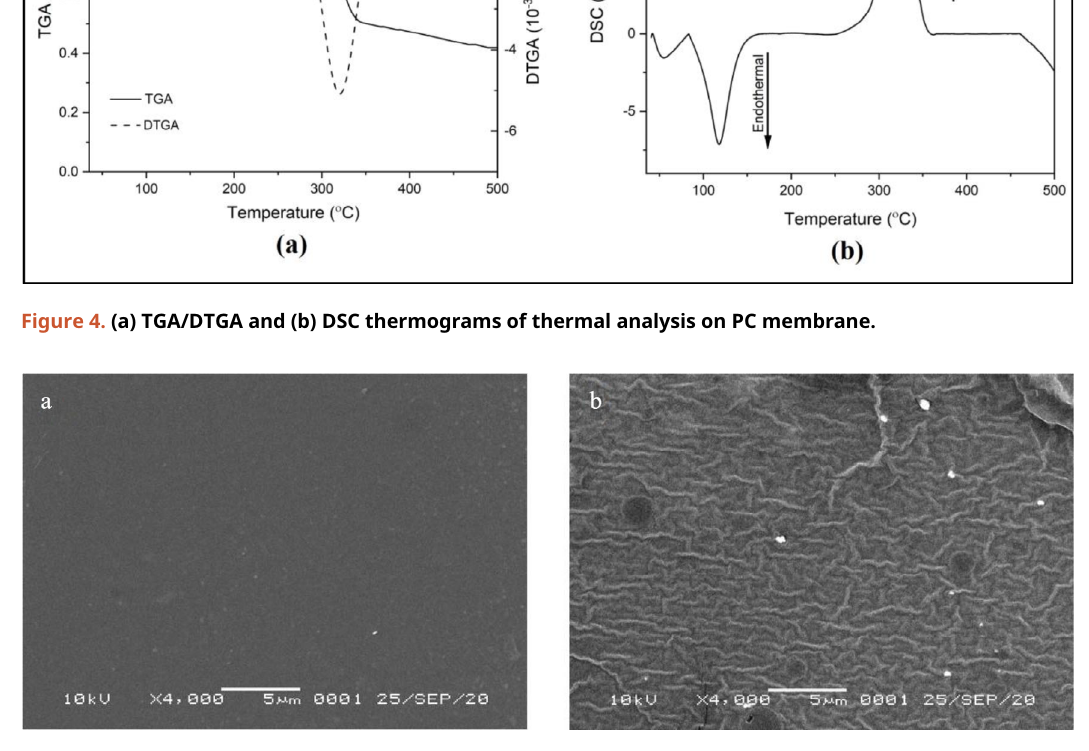
Figure 5. SEM profile of (a) PC and (b) ACN/PC membranes.